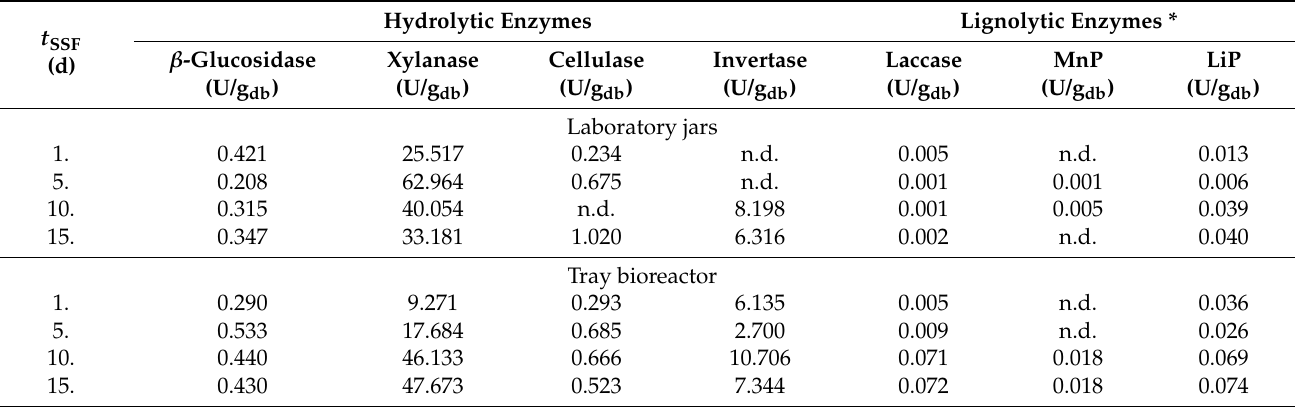
Table 6. Hydrolytic and lignolytic enzyme activities during SSF (day 1, 5, 10, and 15) of GP by R. oryzae in laboratory jars and tray